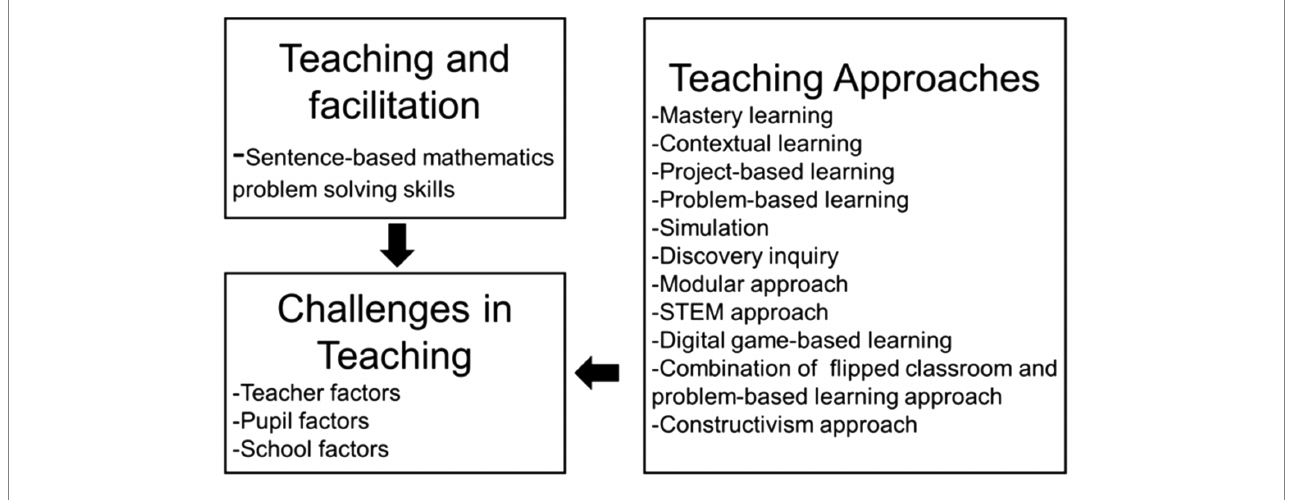
FIGURE 1 Conceptual framework of the